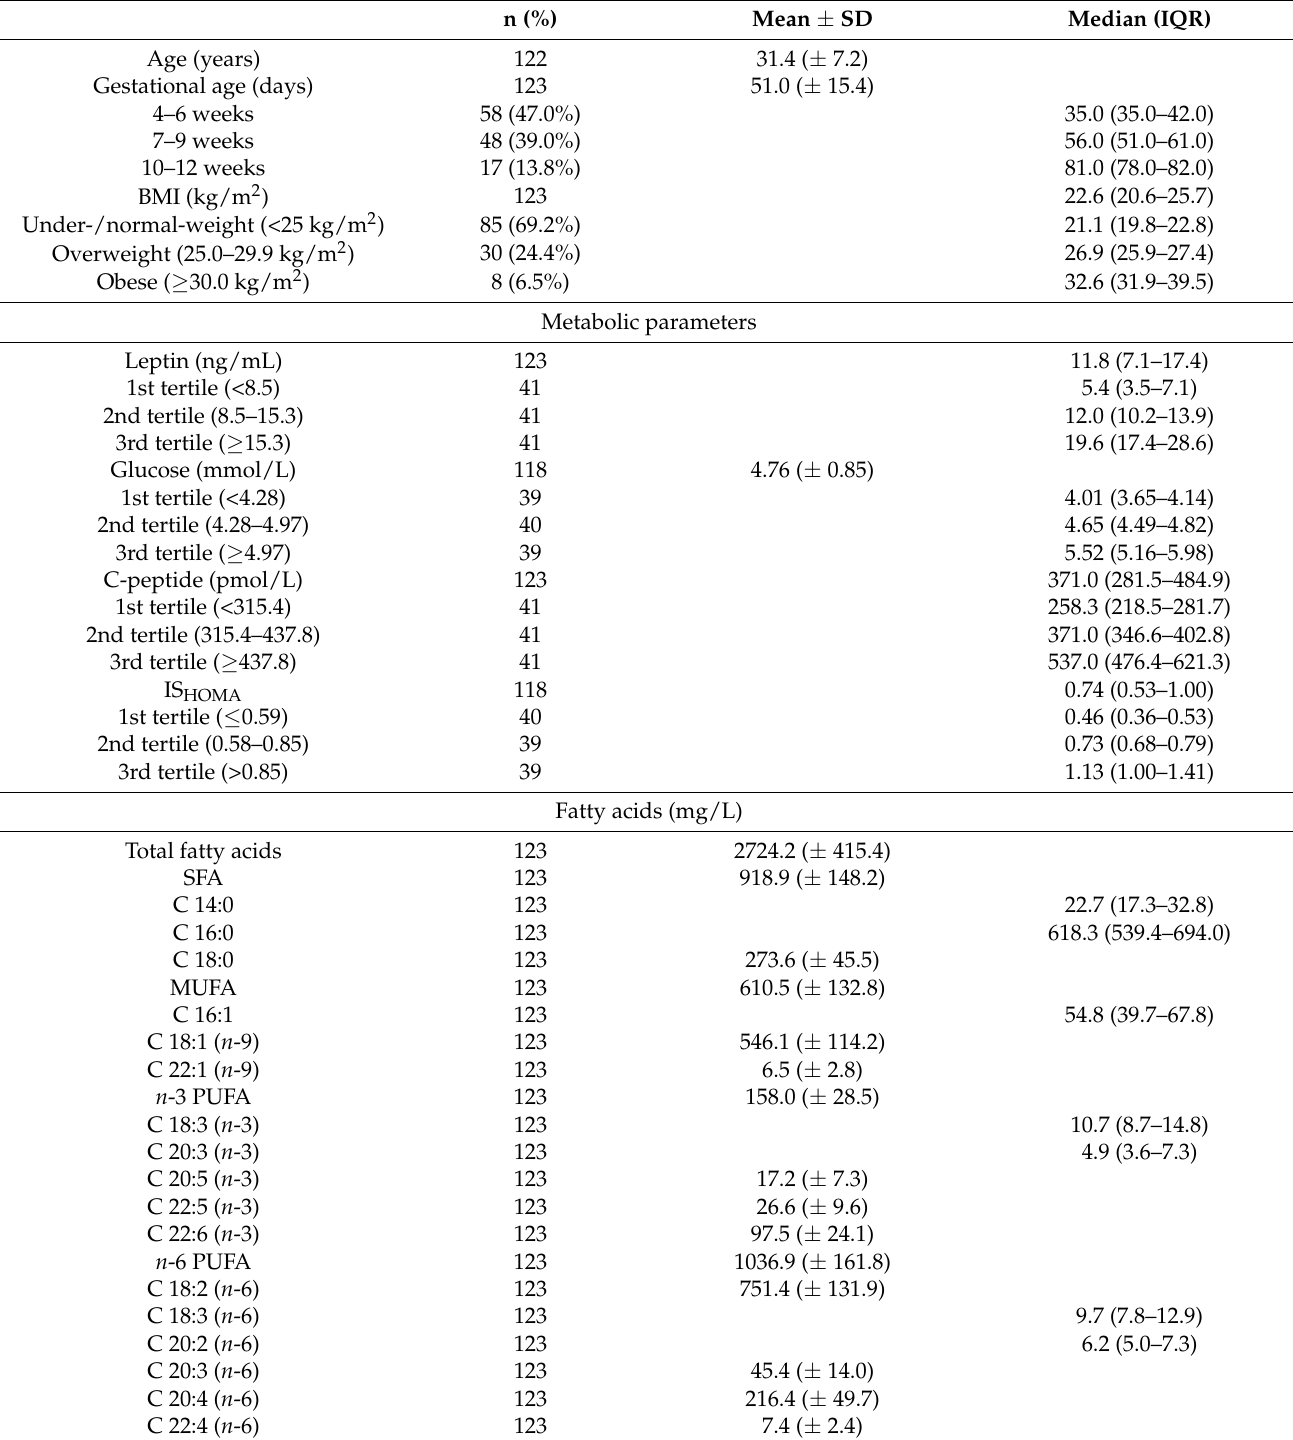
Table 2. Characteristics of study participants (N =